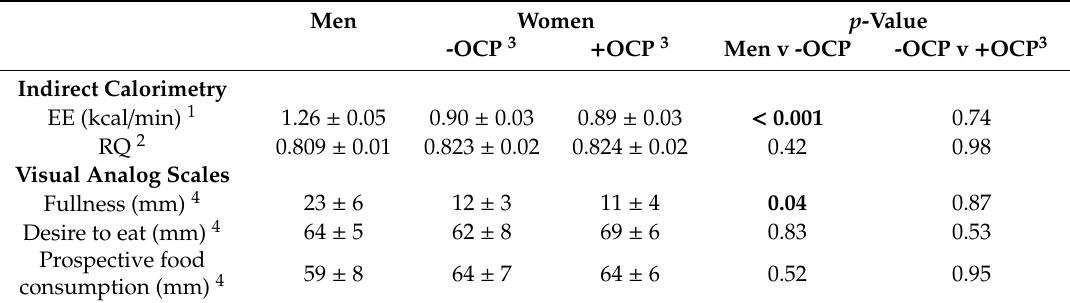
Table 3. Baseline (fasted) parameters (3 day mean ±